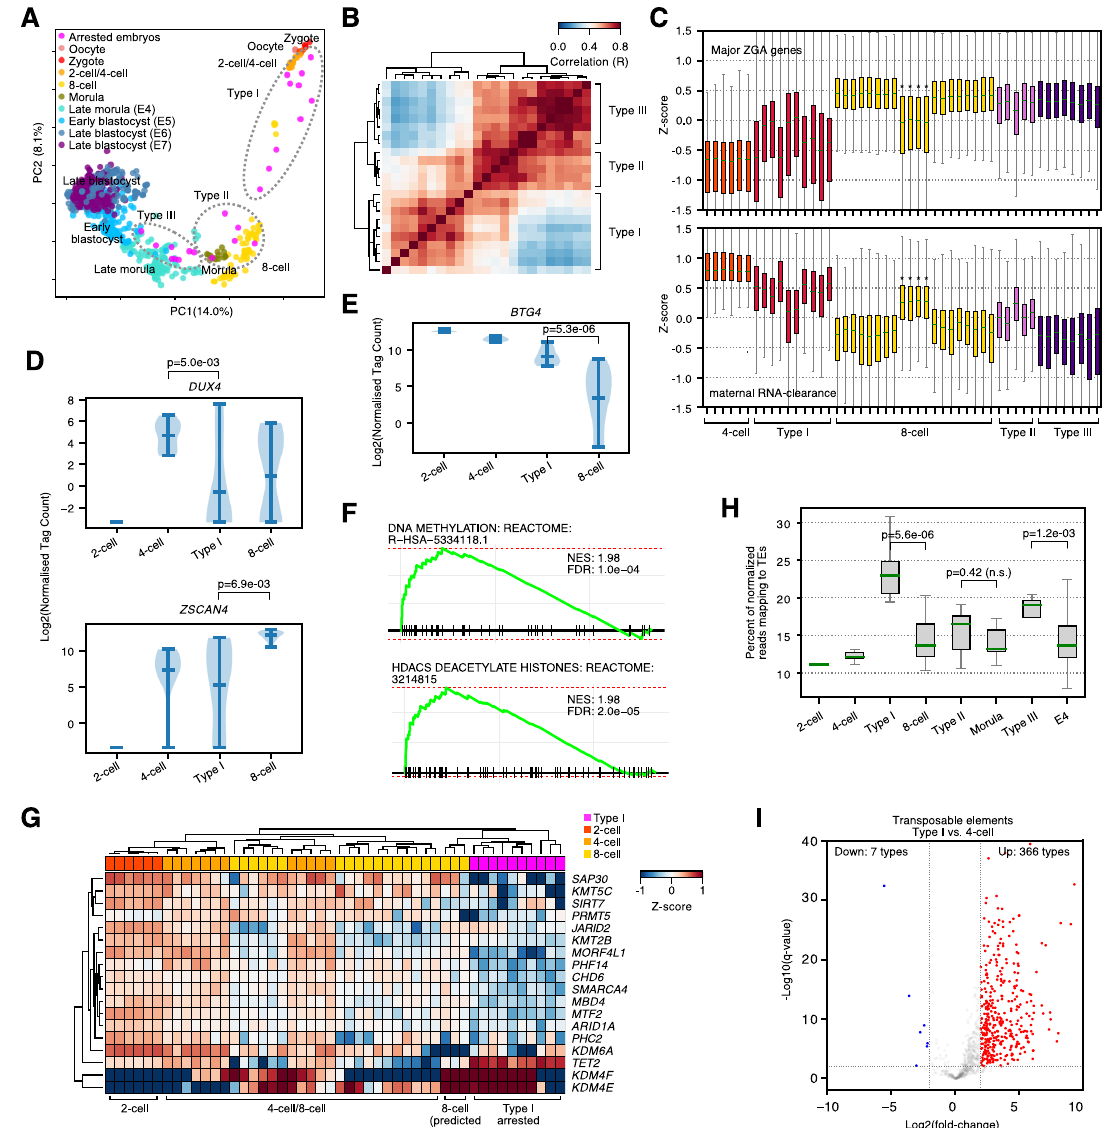
Fig 2. Arrested embryos adopt 3 distinct types of arrest. ( A ) PCA of single embryo or single-cell RNA-seq for normal or arrested human embryos. Arrested embryos are marked in pink. Presumed normal embryonic cells are colored by their developmental stage. The control (non-arrested presumed normal) samples are from a reanalysis of GSE66507 [18], PRJEB11202 [19], and GSE36552 [17] embryonic data. E = Embryonic-stage samples, as defined in [19], for this and all subsequent figures. Underlying data can be found in: https://figshare.com/articles/dataset/Human_embryo_normalized_gene_expression_data/19775992. ( B ) Pair-wise co-correlation matrix (Pearson’s R) of the arrested embryo RNA-seq data. The types (based on the major clades in each cluster) are indicated. Clustering is based on Euclidean distance with complete linkage and optimal ordering. Underlying data can be found in: https://figshare.com/articles/ dataset/Human_embryo_normalized_gene_expression_data/19775992. ( C ) Box plots showing the expression in each cell/embryo for the major ZGA genes and maternal RNA clearance genes as defined in S3A Fig and S3 Data . Cell types are labeled in the colored header bar and labeled below the heatmap. Note that the “normal” 8-cell from the [17] dataset, which appears to be failing the MZT and we predict is arrested, is indicated with stars. Underlying data can be found in: https://figshare.com/articles/dataset/Human_embryo_ normalized_gene_expression_data/19775992. ( D ) Violin plot showing the expression of the key ZGA genes DUX4 and ZSCAN4 . Significance is from a 2-sided Welch’s t test. Underlying data can be found in: https://figshare.com/articles/dataset/Human_embryo_ normalized_gene_expression_data/19775992. ( E ) Violin plot of expression for the key maternal RNA clearance gene BTG4 . Significance is from a 2-sided Welch’s t test. Underlying data can be found in: https://figshare.com/articles/dataset/Human_embryo_normalized_ gene_expression_data/19775992. ( F ) GSEA showing significantly enriched gene set terms for the up-regulated genes in the Type I arrested embryos versus 8-cell-stage embryos. Underlying data can be found in S3 Data . ( G ) Heatmap of the Z-scores of the expression of a selection of differentially expressed epigenetic factors. Cells/embryos were clustered according by Euclidean distance and complete